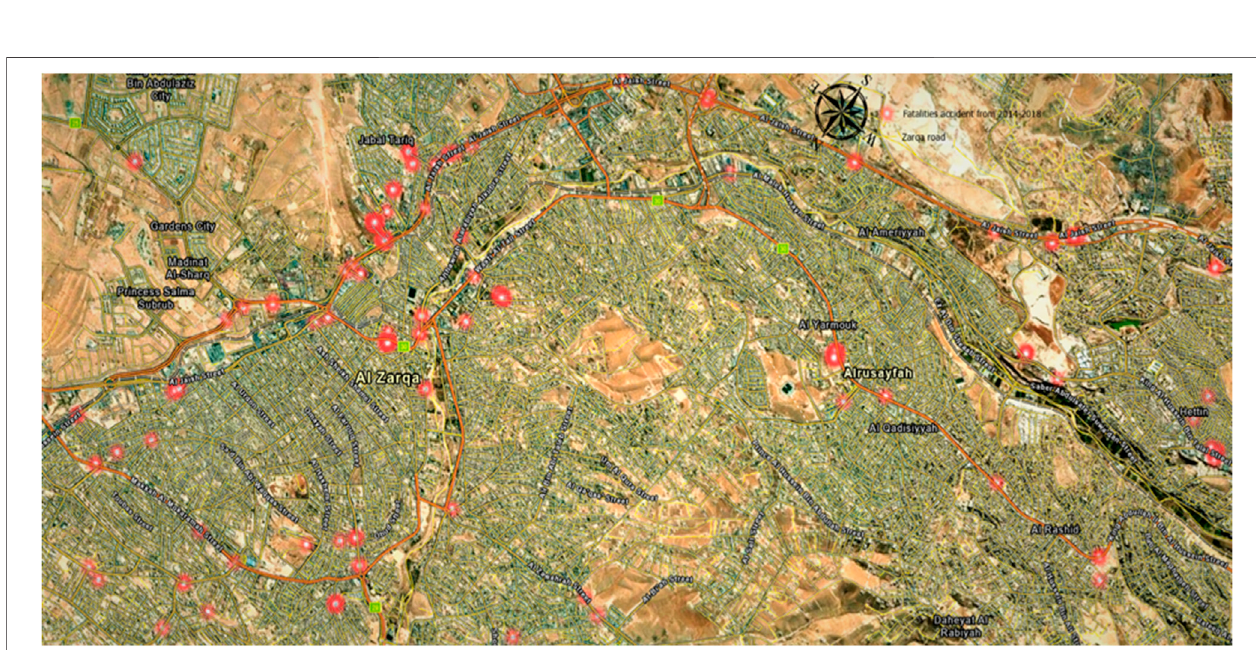
FIGURE 6 | Fatality crashes for Zarqa City in 2014 ––